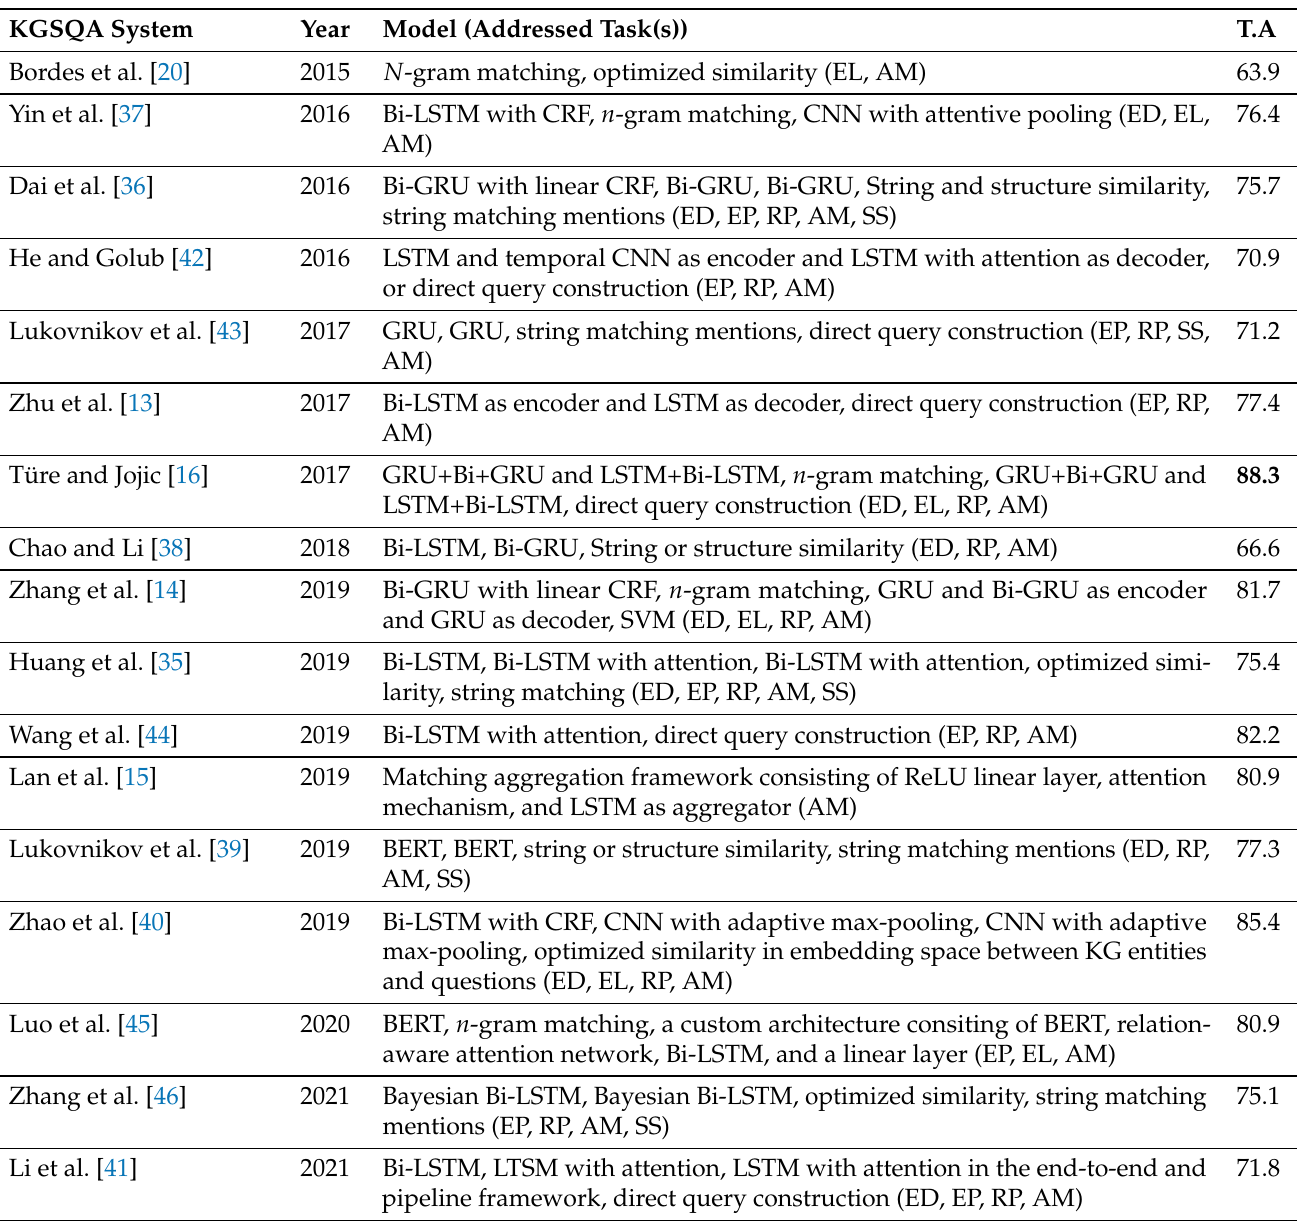
Table 6. Trends and state-of-the-art performance of KGSQA systems on the SimpleQuestions benchmark data set and Freebase KG. T.A. refers to Testing Accuracy in